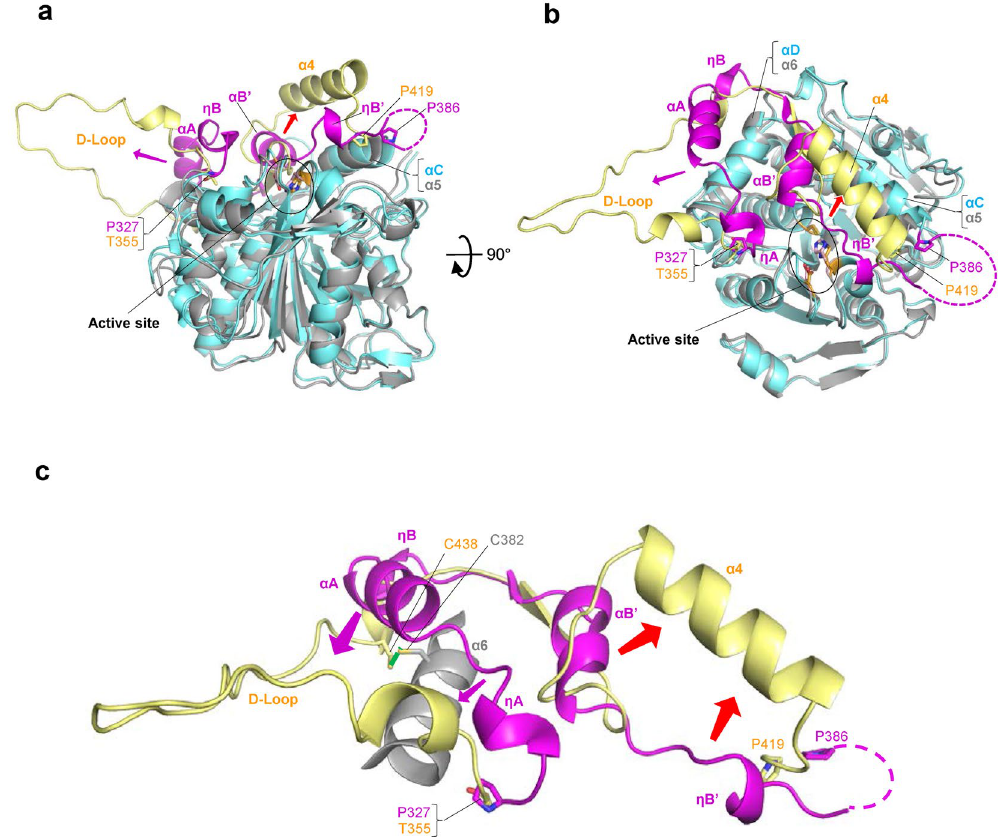
Figure 4. Conformational changes in the CAP subdomain as revealed by structural comparison of PhaC Cs - CAT and PhaC Cn -CAT structures. ( a ) A side-view of the overlay between PhaC Cs -CAT (cyan and magenta) and PhaC Cn -CAT (gray and yellow) with an overall r.m.s. deviation of 2.7 Å for C α carbon atoms. The major conformational deviations are observed in part of the CAP subdomain, the LID region (residues Pro327– Pro386 in magenta) of PhaC Cs -CAT, which corresponds to the segment Thr355–Pro419 (yellow) of PhaC Cn - CAT. Arrows indicate conformational transitions of the LID region from PhaC Cs -CAT to PhaC Cn -CAT. ( b ) As in a , but a top-view down to the active site. A narrow path to the active site was found in PhaC Cn -CAT, whereas the path is covered by the LID region in PhaC Cs -CAT. ( c ) To clarify the conformational transitions found by the structural comparison of PhaC Cs -CAT and PhaC Cn -CAT, overlay of the LID regions of the two structures are shown. Unfolding of η A, α A and η B helices of PhaC Cs -CAT into a long flexible D-loop found in PhaC Cn -CAT is indicated by magenta arrows, and refolding of α B’ and η B’ helices and their linker loop of PhaC Cs -CAT into a long α 4 helix in PhaC Cn -CAT by red arrows. The disulfide bond between Cys328 and Cys438 of PhaC Cn -CAT is shown in